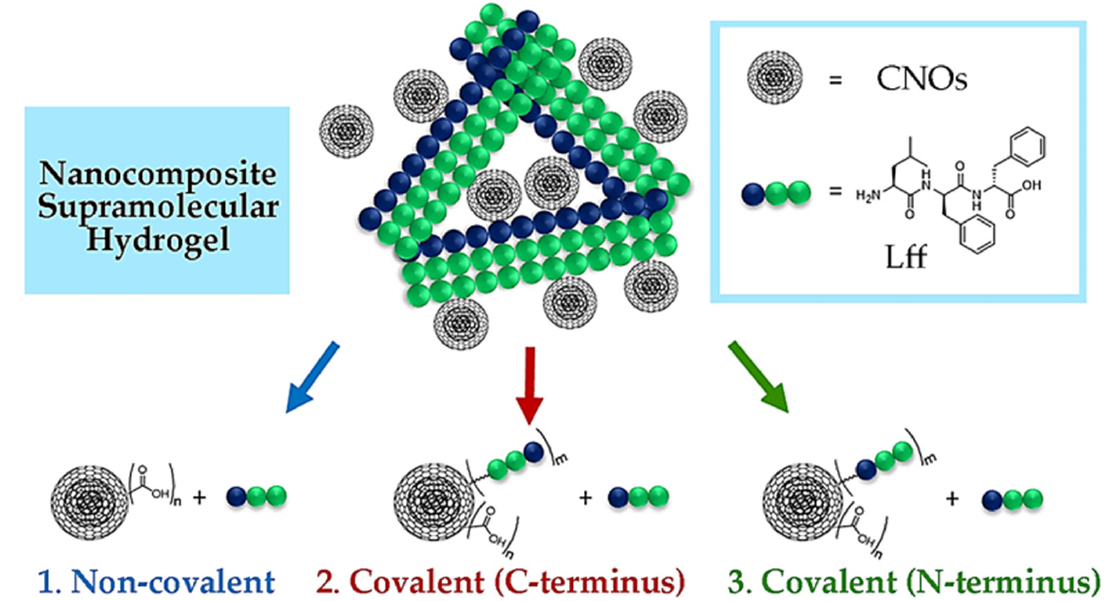
Figure 1. Nanocomposite supramolecular hydrogels from CNOs and the self-assembling tripeptide (Lff) were envisaged through three strategies.